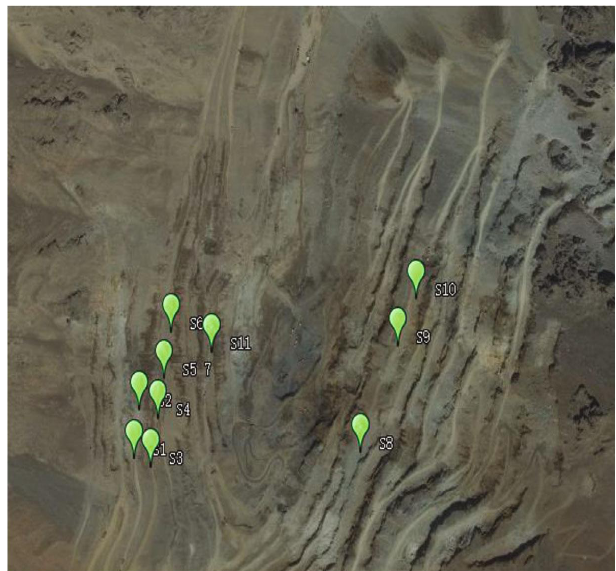
Figure 1: Study area.